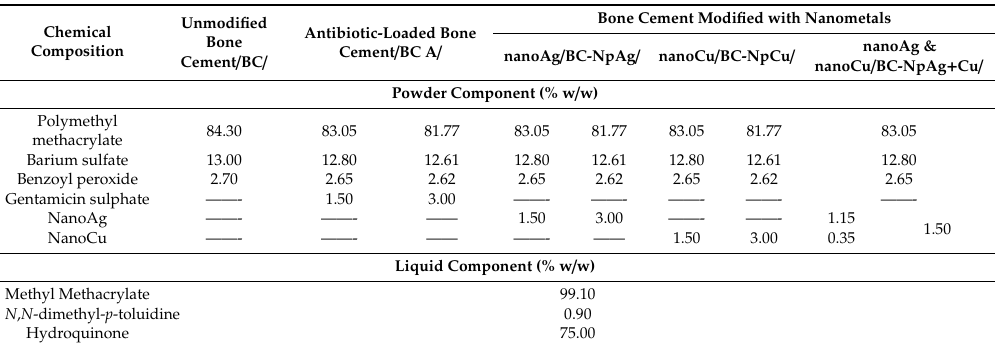
Table 1. Chemical composition of bone cements used for the